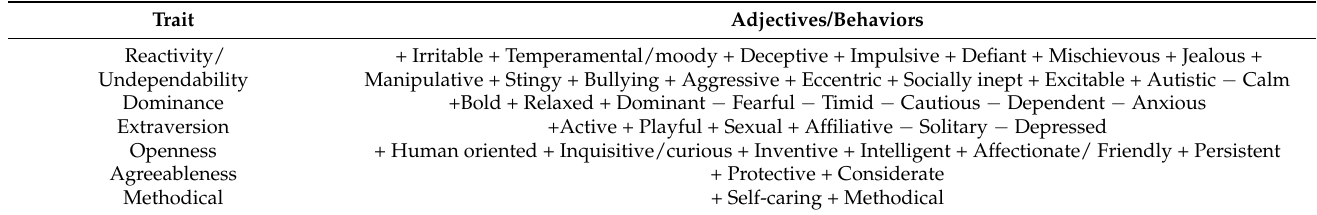
Table 1. Adjective loadings for varimax-rotated chimpanzee personality traits. Trait Adjectives/Behaviors Reactivity/